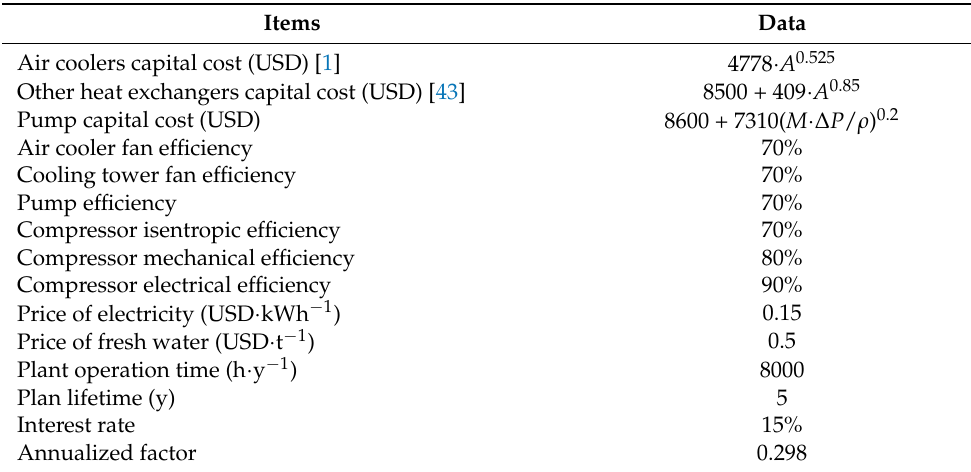
Table 3. Economic parameters of case study.